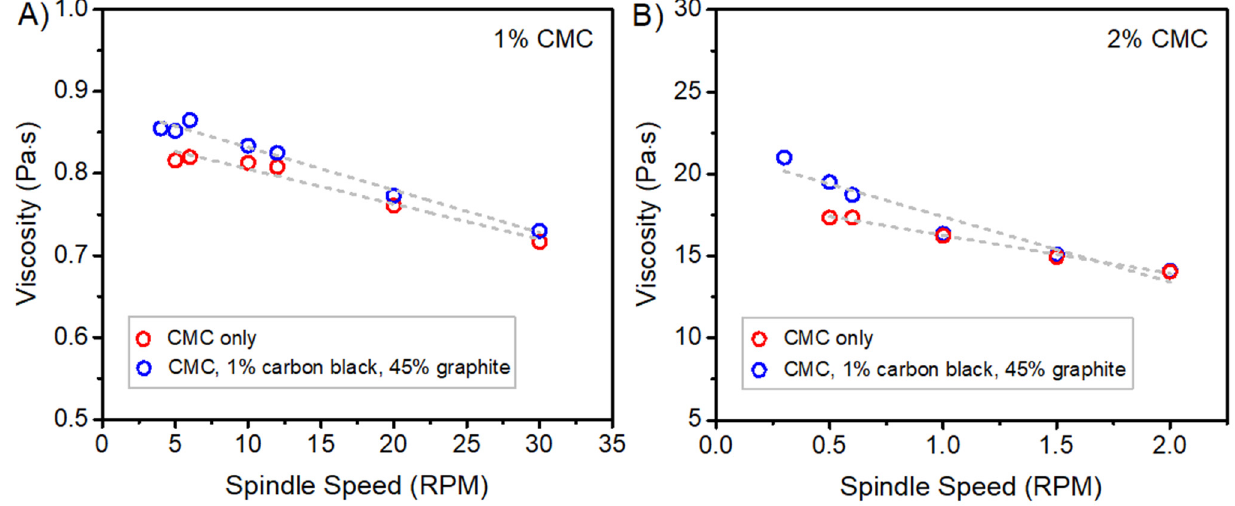
Figure 1. Viscosity versus spindle speed of ( A ) 1% carboxymethyl cellulose (CMC) and 1% CMC, carbon black and graphite slurries; ( B ) 2% CMC and 2% CMC, carbon black, and graphite slurries.